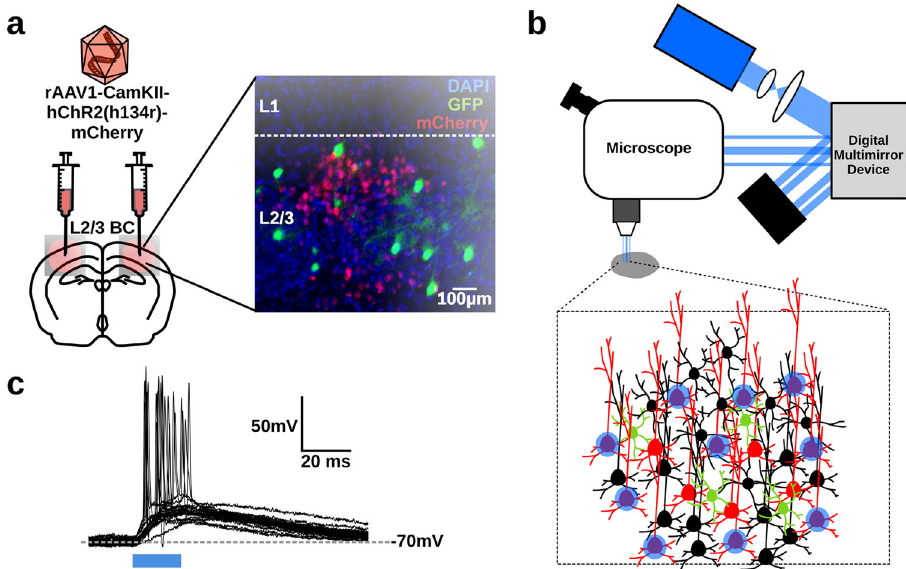
Fig. 2 Patterned optical stimulation of ChR2 + Layer 2/3 Pyramidal Neurons. a Viral transfection of Channelrhodopsin-2 into L2/3 Pyramidal Neurons. b Illustration of patterned optical stimulation protocol. c Sample responses from ChR2 + layer 2/3 pyramidal neurons ( n = 19) to a 15 μ m spot placed directly over the soma of the recorded neuron.